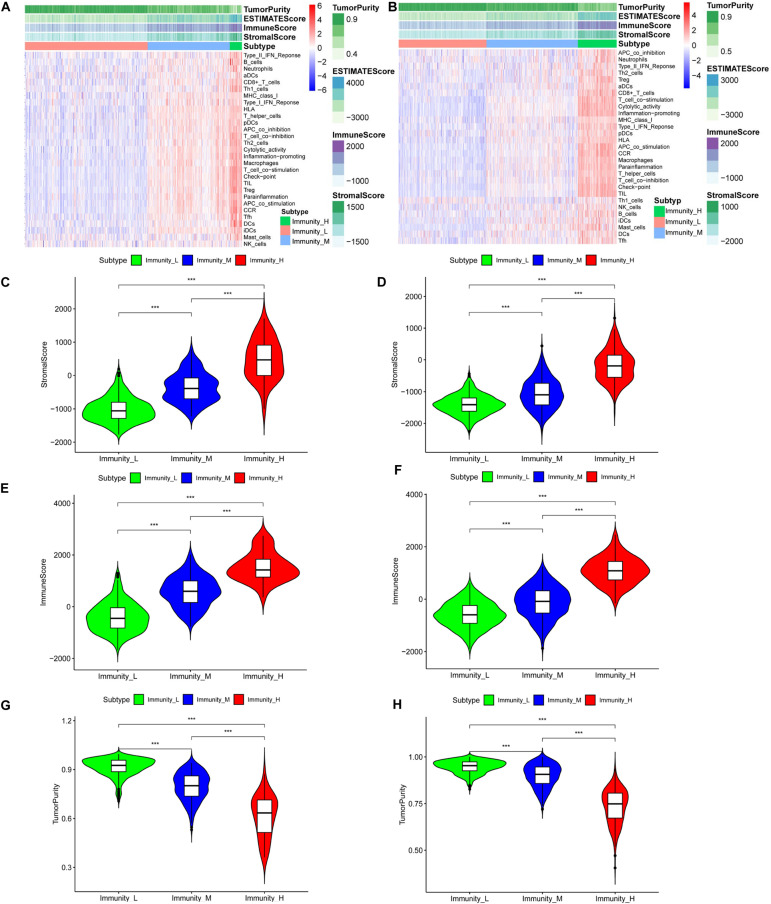
The tumor immune microenvironment is related to the expressed immune genes. Heatmaps of the tumor immune microenvironment in the TCGA (A) and CGGA (B) datasets. Violin plots of the stromal cell scores among immune groups in the TCGA (C) and CGGA (D) datasets. Violin plots of the immune scores among the immune groups in the TCGA (E) and CGGA (F) datasets. Violin plots of tumor purity in the TCGA (G) and CGGA (H) datasets, ***P < 0.001.